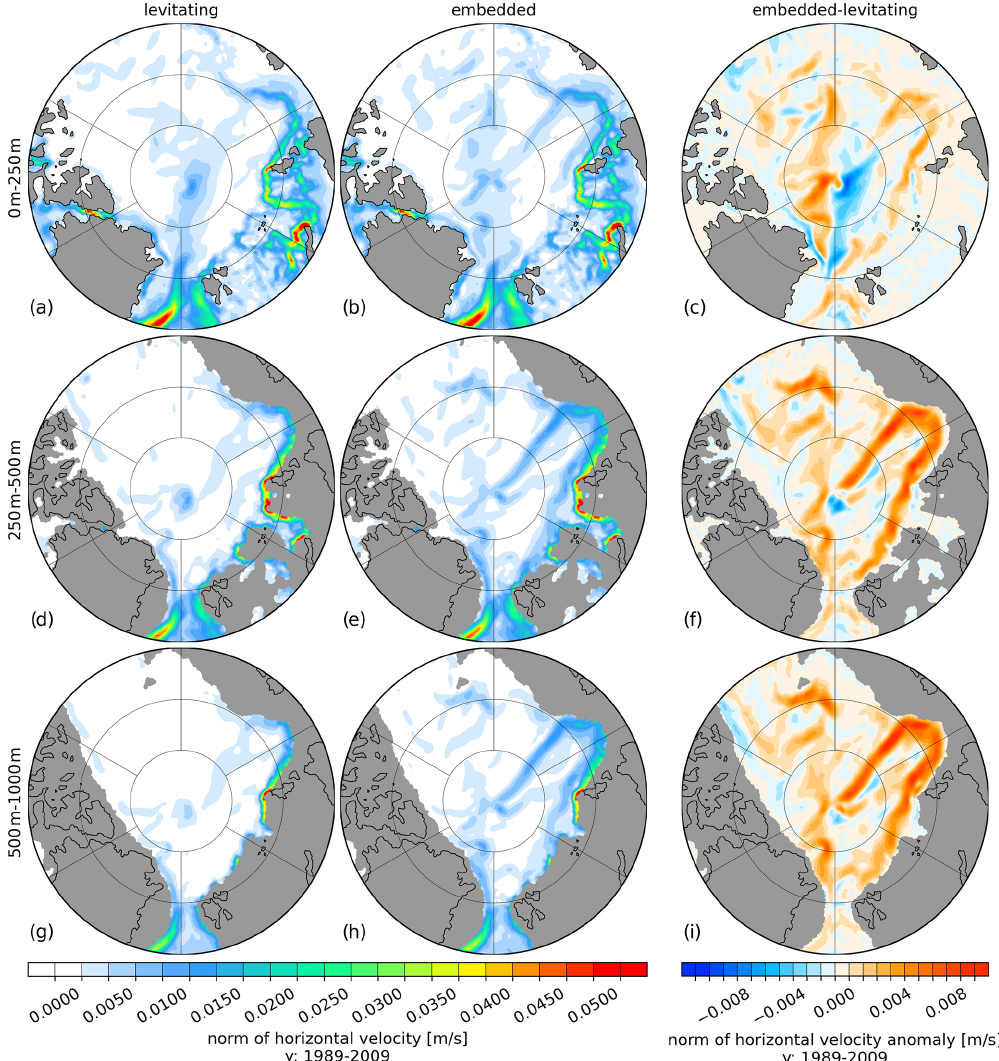
Figure 8. Norm of ocean velocity for levitating sea ice ( a, d, g ) and embedded sea ice ( b, e, h ) and the difference between embedded and levitating sea ice ( c, f, i ) averaged for the period 1989 to 2009. The panels show, from top to bottom, the vertically averaged fields for the depth ranges of 0–250, 250–500 and